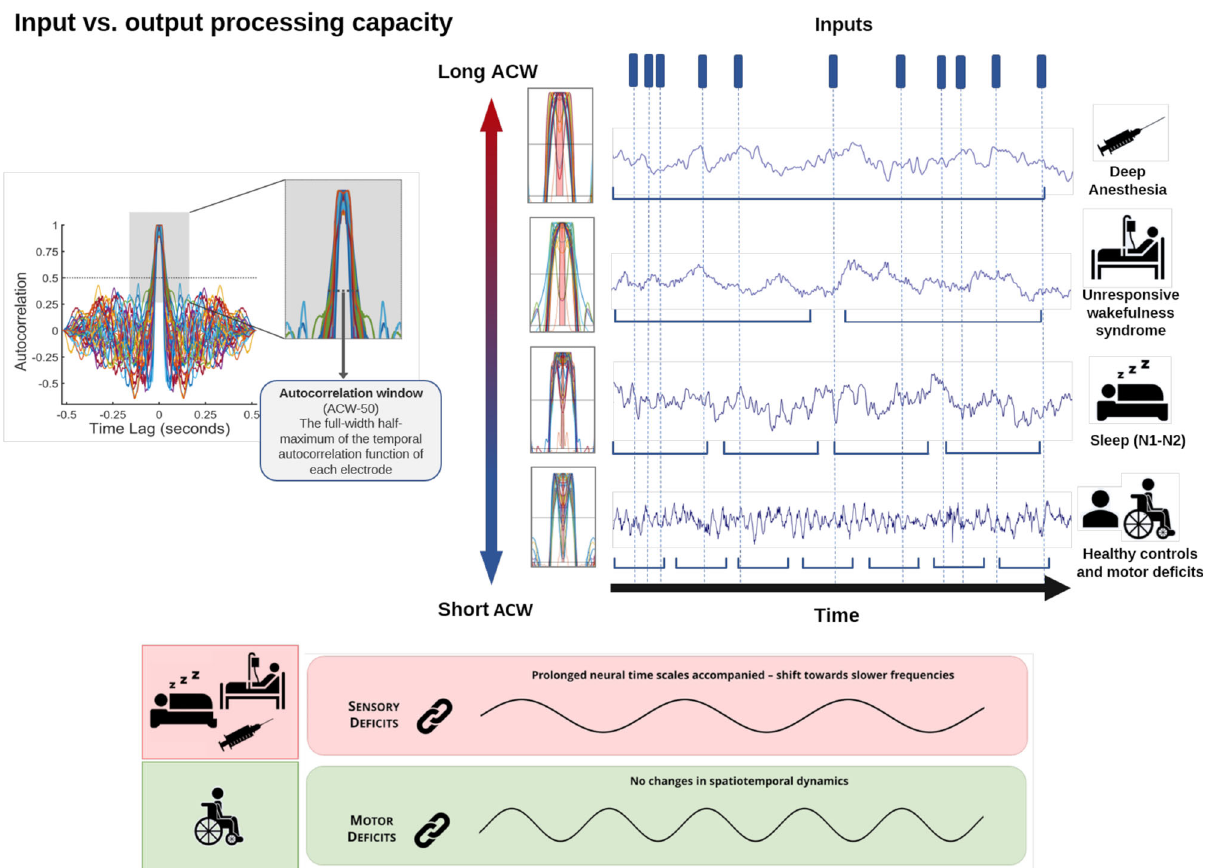
Fig. 3 Input vs. output processing. On a whole-brain level, healthy awake subjects and subjects with motor de fi cits but preserved input processing (amyotrophic lateral sclerosis, locked-in syndrome) present short ACW, i.e., normal neural timescales accompanied by a balance of slow and fast frequencies, which is associated with a normal capacity of encoding inputs, while other physiological, pharmacological, and pathological conditions, e.g., sleep (N1-N2), unresponsive wakefulness syndrome and deep anesthesia (e.g., sevo fl urane) show a progressive stretching of the ACW, i.e., prolonged neural timescales accompanied by a shift towards slower frequencies, which consequently lead to the abnormal prolongation of the input processing temporal window (the EEG signals and the ACW representations are taken from the datasets investigated in Zilio et al. 21